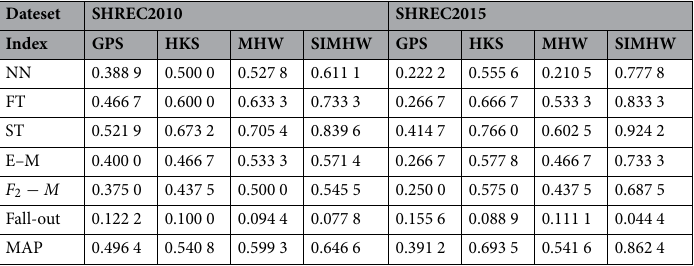
Table 3. Retrieval values based on the SHREC2010 and SHREC2015